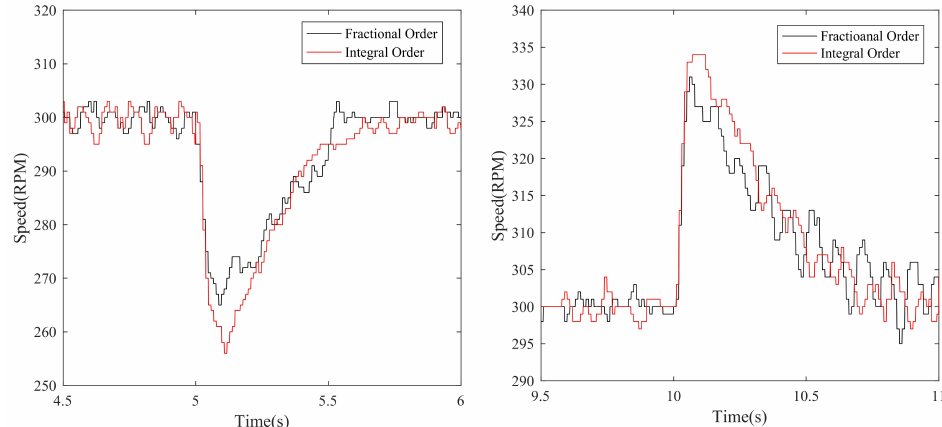
Figure 7. The speed curves with disturbance at low